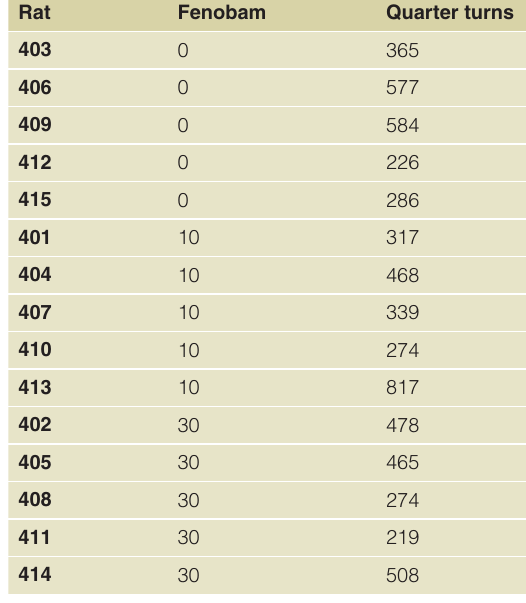
Table S9. Locomotor response (total quarter turns over 90 min) to CDPPB (0, 30, 60 mg/kg).